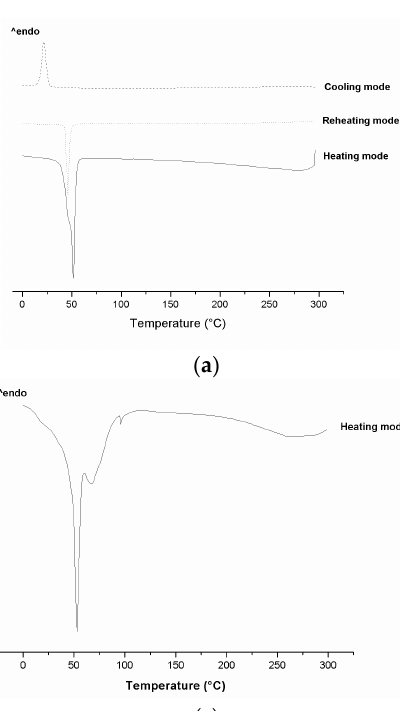
Figure 3. DSC scans of the ingredients used to prepare the SLNs.